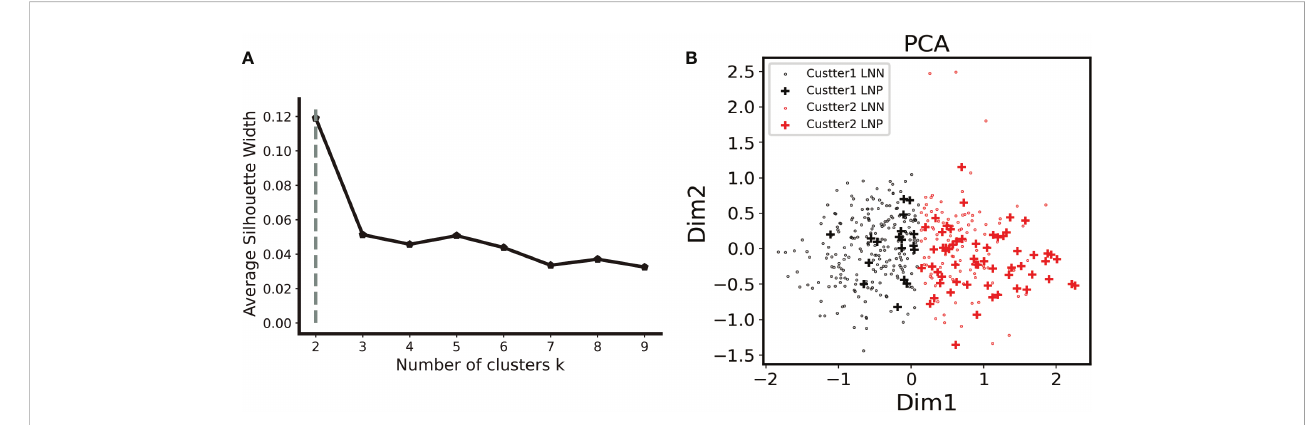
FIGURE 2 Unsupervised clustering analysis. (A) . The elbow curve plot shows that the optimal number of clusters was observed to be two by using K- mean clustering analysis on the PRAD cohort with the 333 DEAS feature. (B) . In the two clusters, cluster two had a 76.6% compactness with LNM. (LNN lymph node negative, LNP lymph node